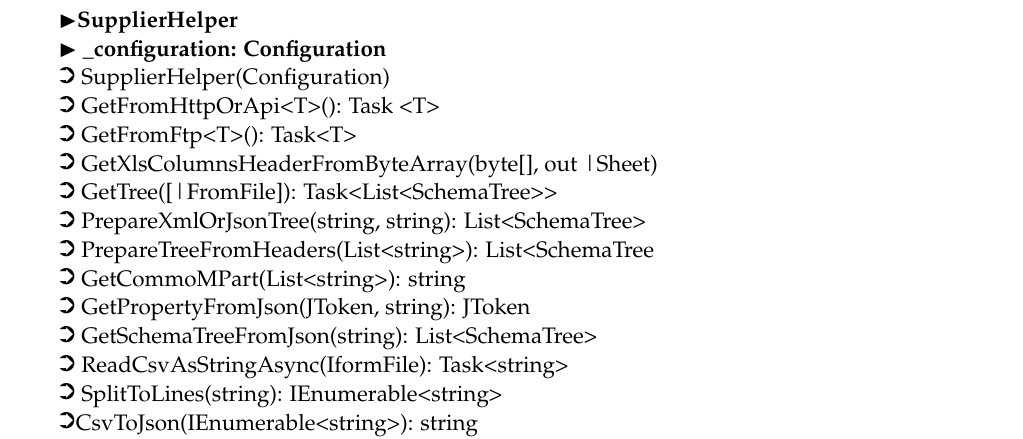
Algorithm 2: Database modification process in relation to the described models. Expan- sion of the database depends on the need to use the SuperService entity in order to cal- culate the estimates.